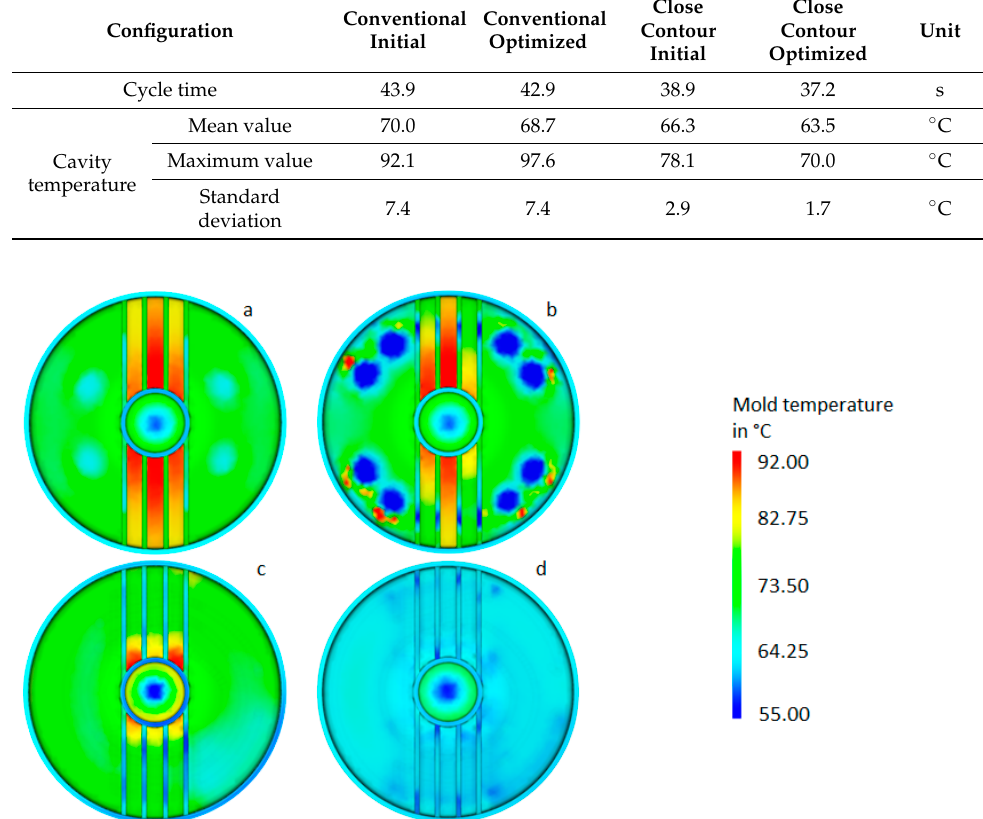
Figure 17. Graphical comparison of the temperature distribution on the lower tool surface: initial configuration ( a ) and optimized conventional configuration ( b ); initial close-contour configuration ( c ) and optimized close-contour cooling system ( d ). Table 8. Comparison of the simulation results for the initial and optimized conventional configu- rations ( left ) with the initial and optimized close-contour configurations ( right ).